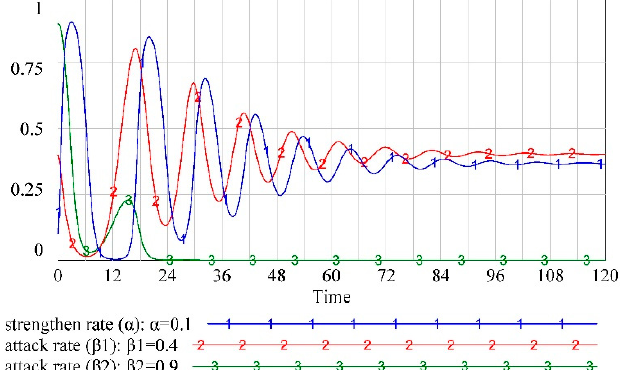
Figure 9. Game results under dynamic penalty scheme ( α = 0.1, β 1 = 0.4, β 2 = 0.9 ) .